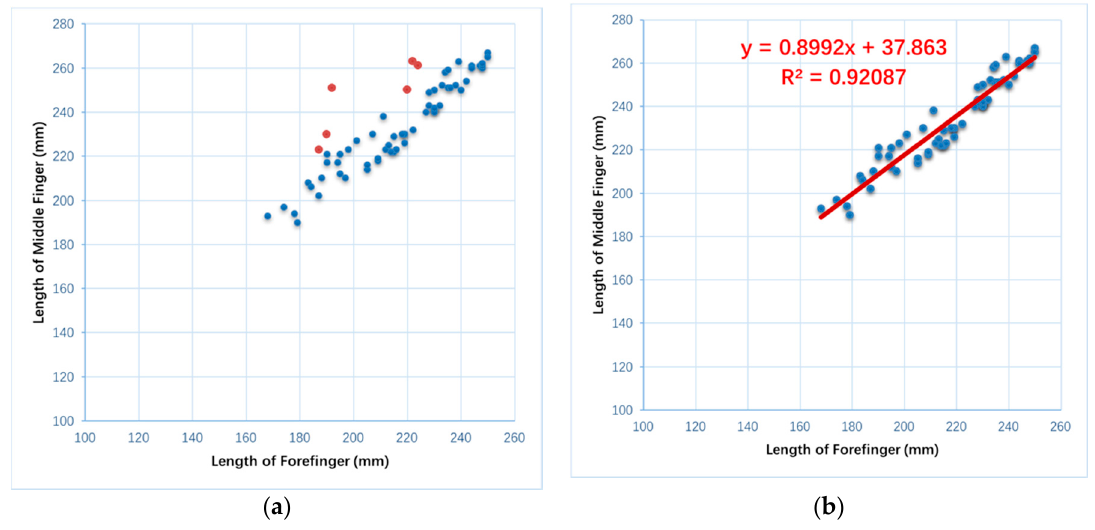
Figure 12. Prediction model: ( a ) hypothesis testing and outlier analysis of the data; ( b ) prediction model of incomplete finger length.